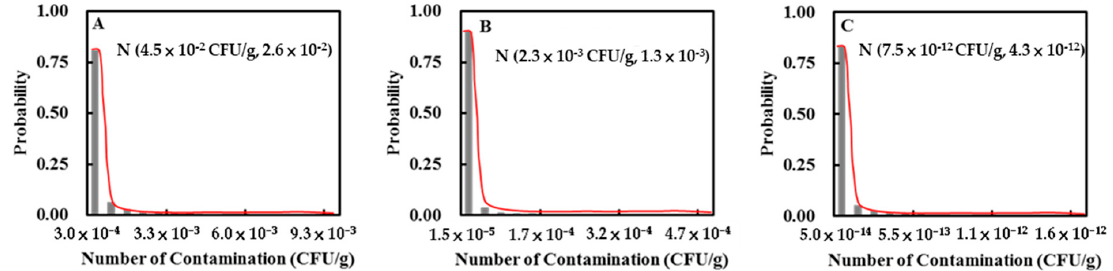
Figure 2. Probability distribution of E. coli O157:H7 contamination in beef imported from the United States of America after cooking to ( A ) rare, ( B ) medium, and ( C ) medium-well. Note: CFU = colony forming units.